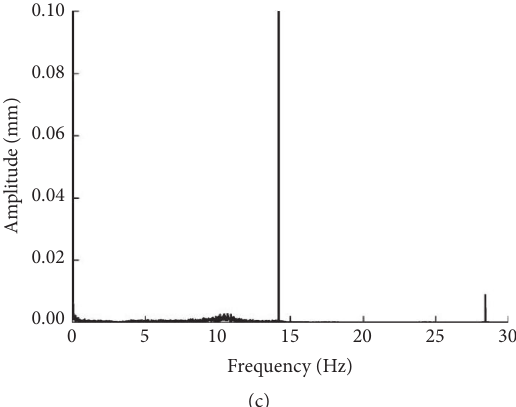
Figure 23: Quasiperiod motion of the system is obtained for the external excitation frequency Ω � 14 . 2Hz: (a) waveform; (b) phase portrait; (c) amplitude spectrum.